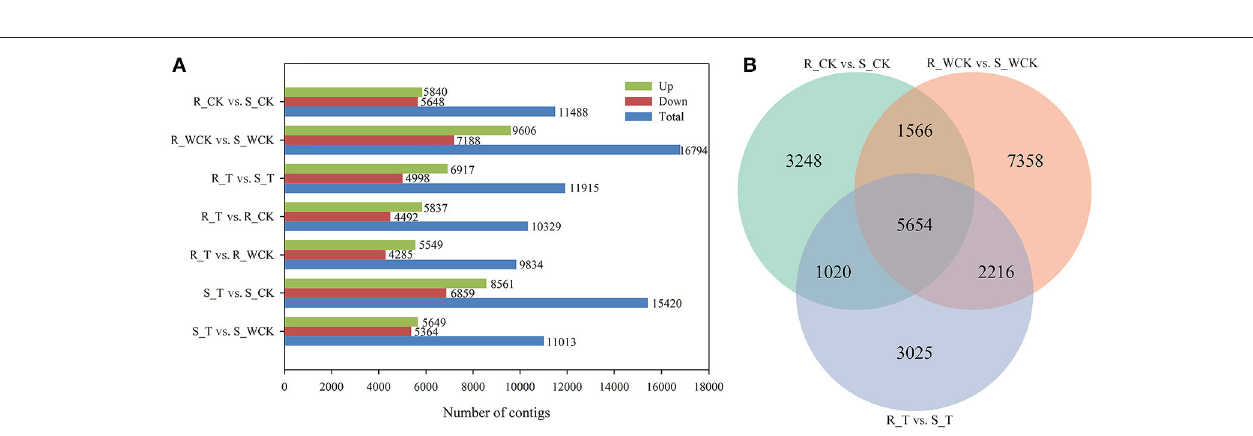
FIGURE 7 | The statistics of the DEGs between the Alopecurus aequalis treatment groups. (A) The number of DEGs between the different groups. (B) Venn diagram showing the number of DEGs between R (AH18) and S (SD01) in the three treatment comparisons.